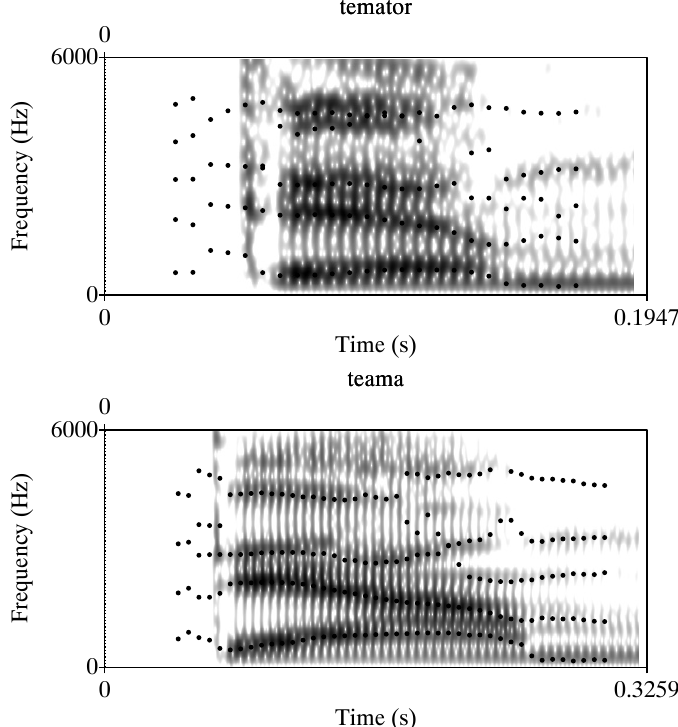
Figure 3. Spectrograms of derived /e/ in [te.m{ ə .'tor}] ‘fearful’ (top) and diphthong /ea/ in ['tea.m{ ə }] ‘fear’ (bottom), as produced by a female speaker. The sounds in curly brackets are not